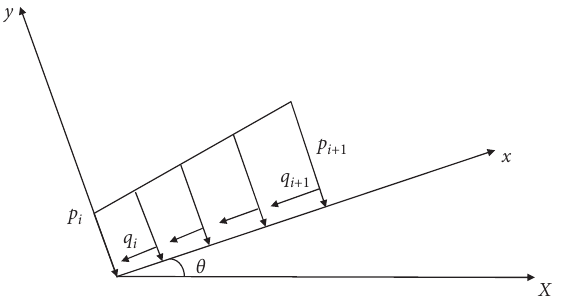
Figure 6: Force diagram for the